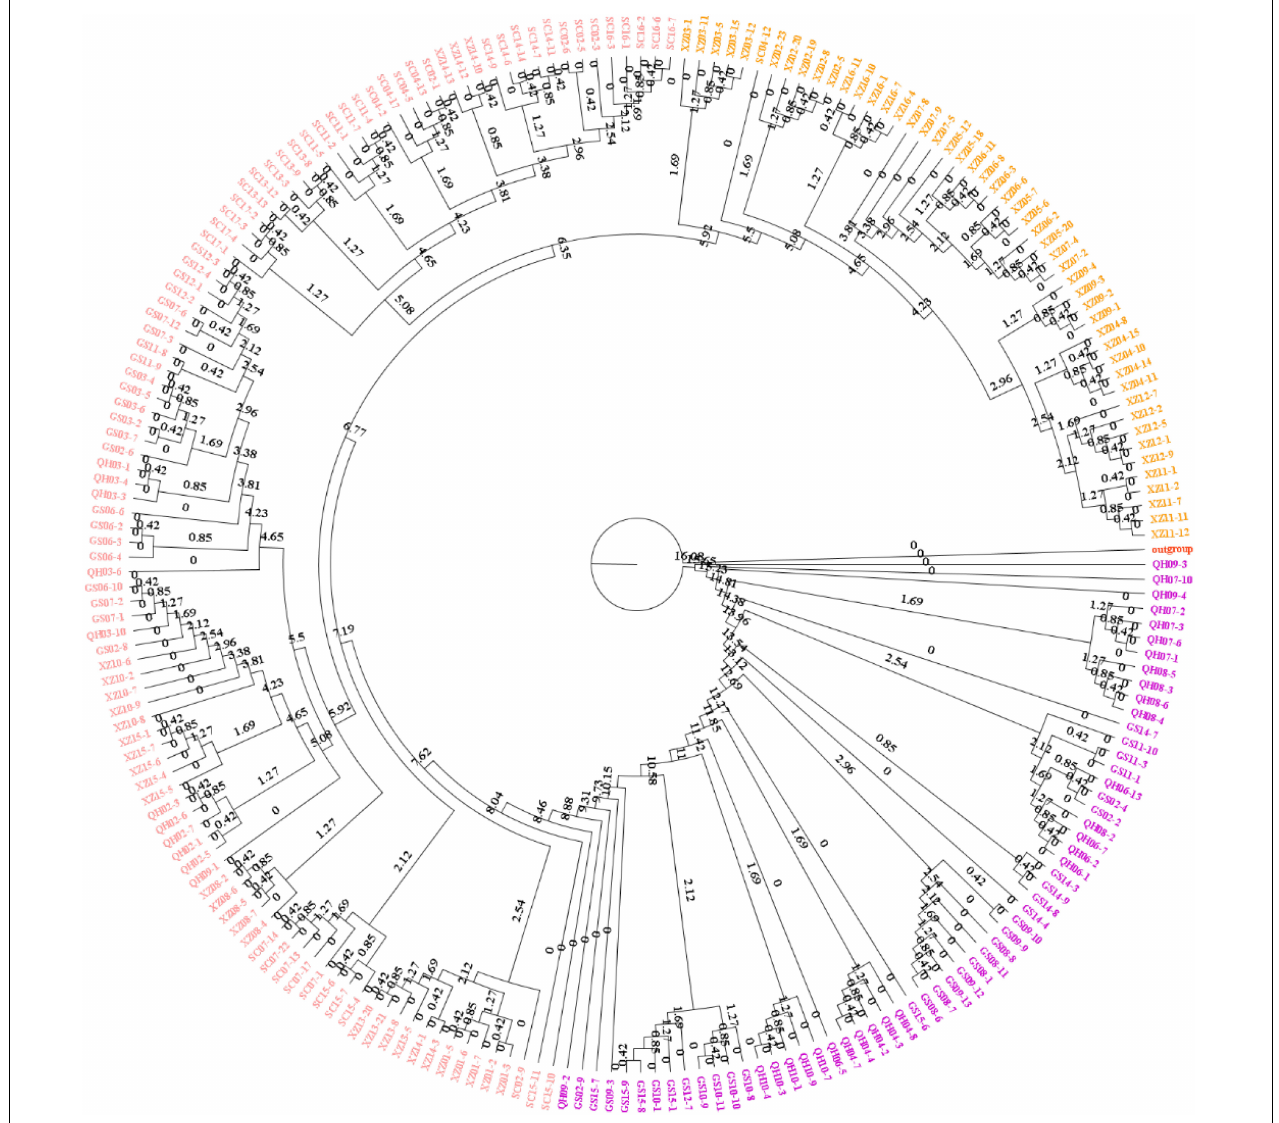
FIGURE 6 | Phylogenetic tree constructed with polymorphic SNPs and divergence time scale between three